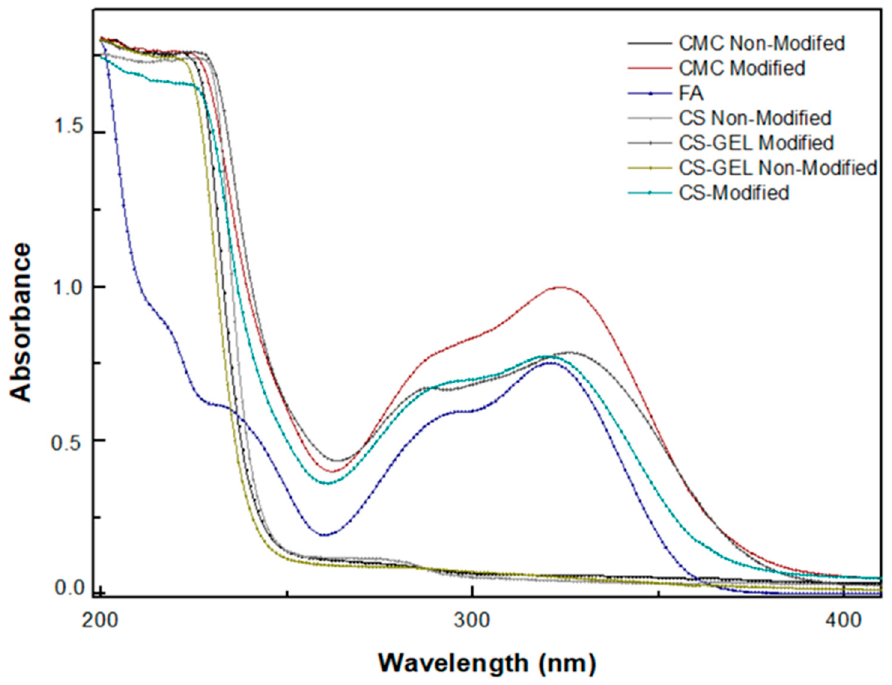
Figure 5. Ultraviolet-visible (UV–Vis) spectra in the range of 200–400 nm of enzymatically modified and non-modified biopolymer membranes dissolved in 1% v / v aqueous acetic acid solution, as well as a ferulic acid (FA) sample with a final concentration of 0.5 mM. Acetic acid solution was used as a control.